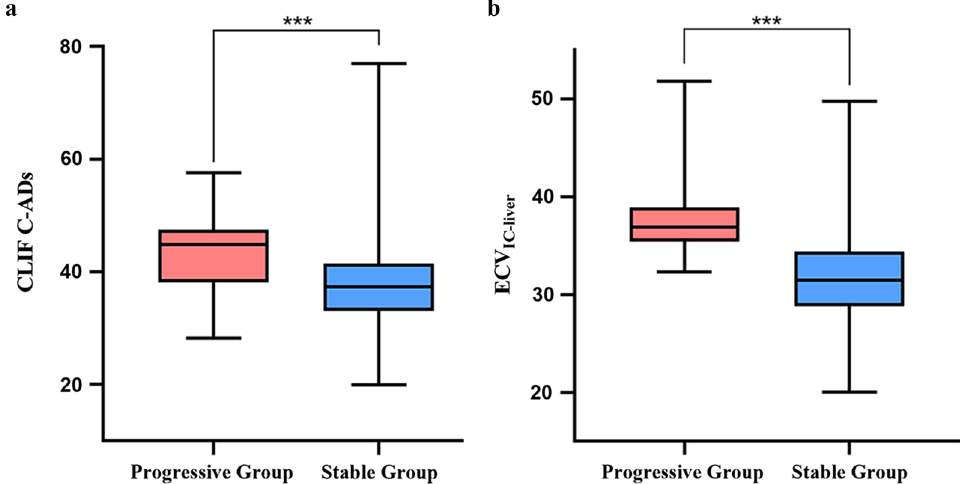
Fig. 2 Box plots of CLIF-C ADs and ECV IC-liver for the progressive and stable groups. CLIF-C ADs, chronic liver failure consortium-acute decompensation score; ECV IC-liver , extracellular liver volume; ***, p <